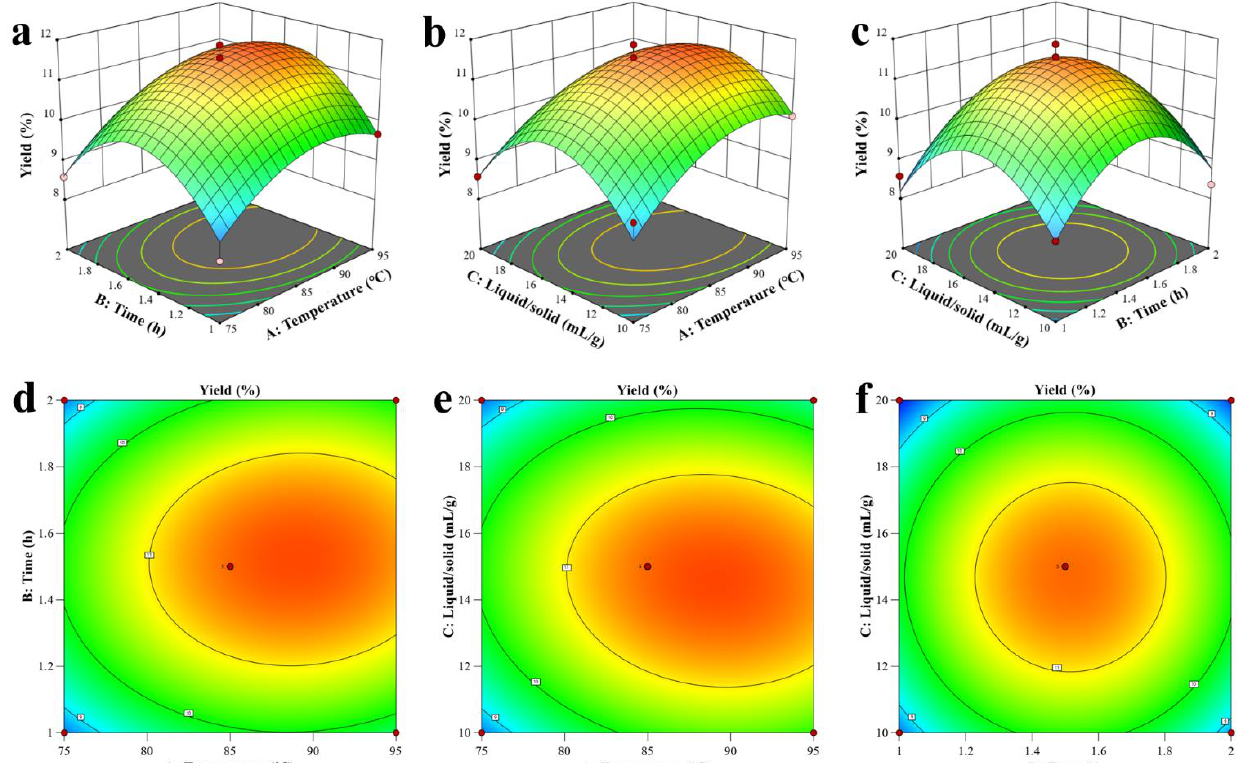
Figure 1. Results of response surface analysis. Response surface plots of the interactions between extraction temperature and time. ( a ) Extraction temperature and liquid:solid ratio. ( b ) Extraction time and liquid:solid ratio. ( c ) A, B, and C represent the extraction temperature, extraction time, and liquid:solid ratio, and ( d - f ) are their contour plots, respectively.